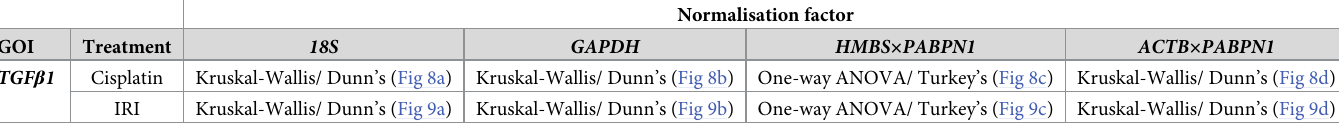
Table 13. Statistical methods used to analyse TGF β 1 gene expression.